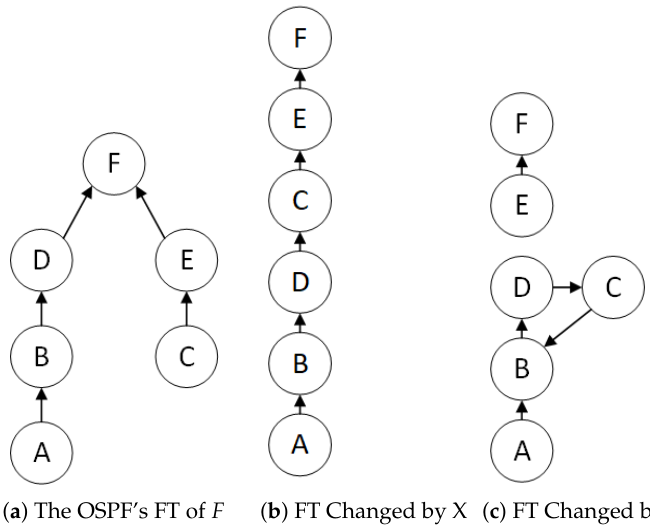
Figure 6. The Migration of The Forwarding Tree of Figure